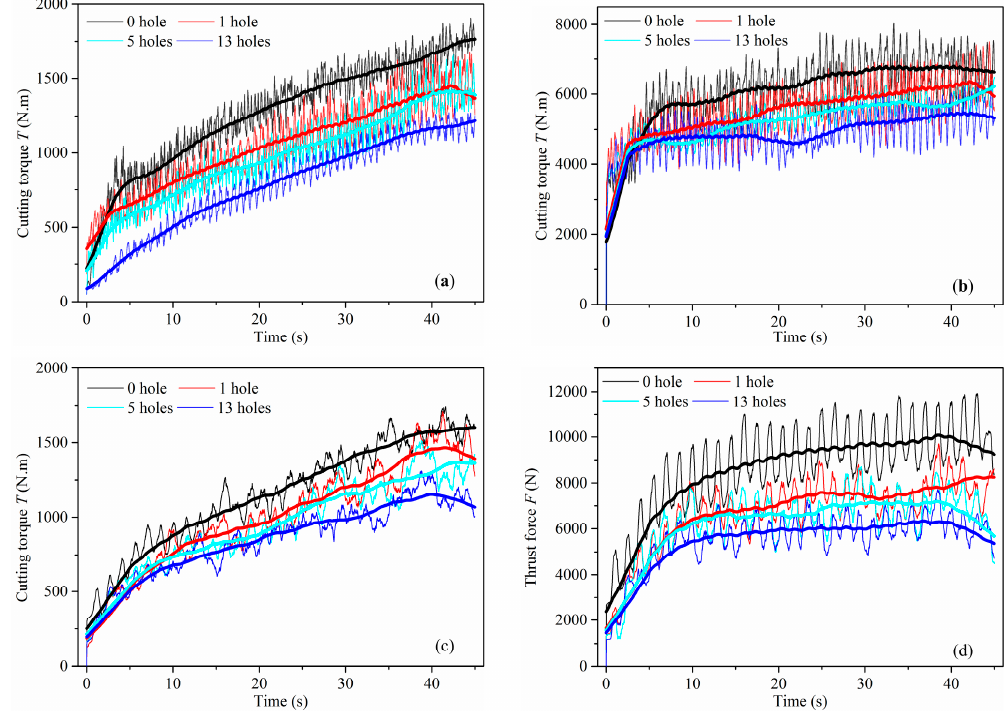
Figure 5. Graphs of data with different numbers of holes: ( a ) experimental torque and ( b ) force; ( c ) numerical torque and ( d ) force.